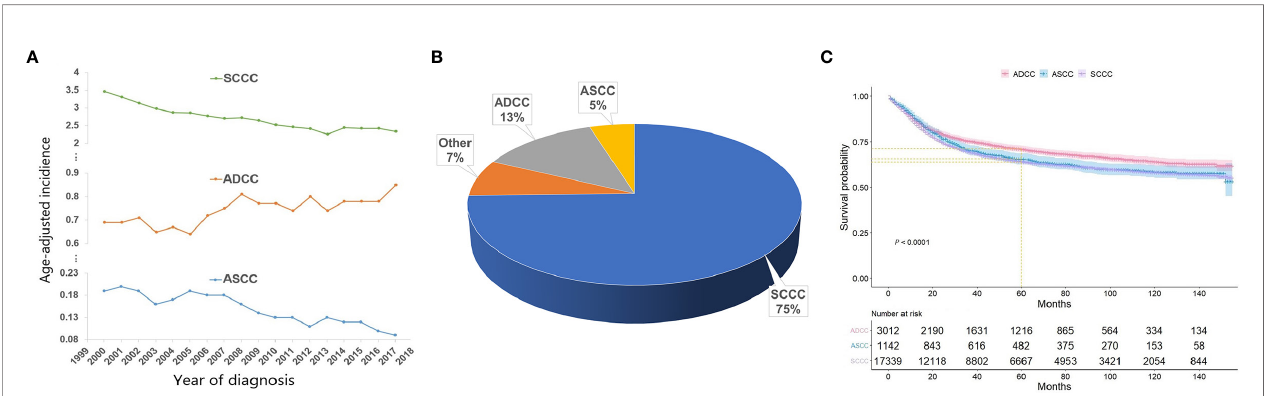
FIGURE 1 | The age-adjusted incidence of ASCC, ADCC, and SCCC between 2000 and 2017 (A) ; Proportion of different histological subtypes of cervical cancer (B) ; Kaplan-Meier curves showing cancer-speci fi c survival of patients with ASCC, ADCC, and SCCC (C)